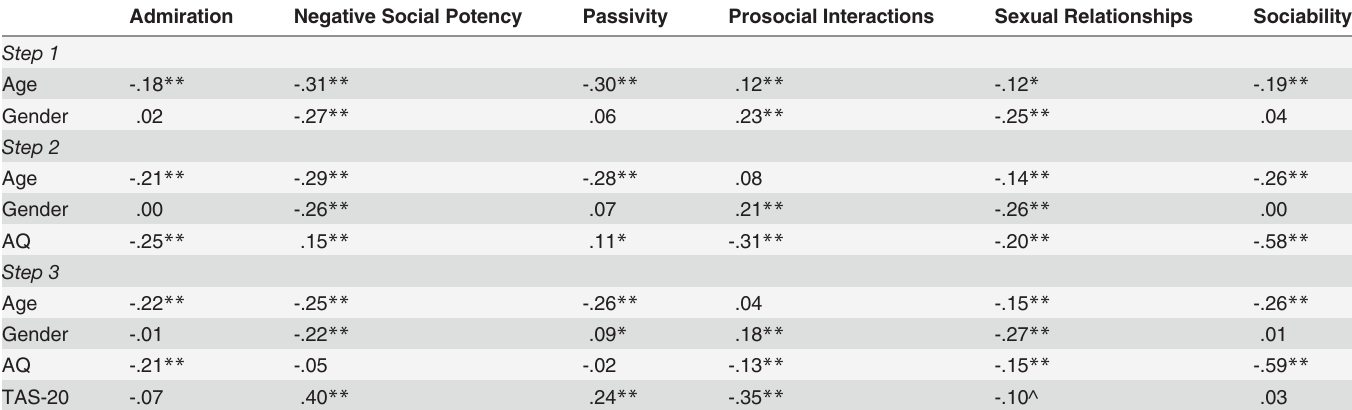
Table 3. Results from hierarchical regression models predicting subtypes of social reward.